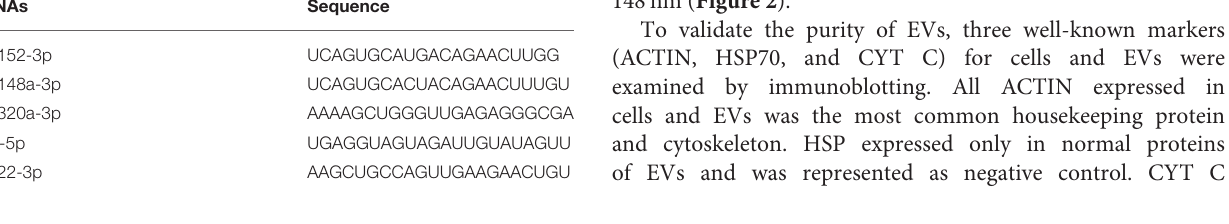
TABLE 3 | Sequence selected of miRNAs. miRNAs